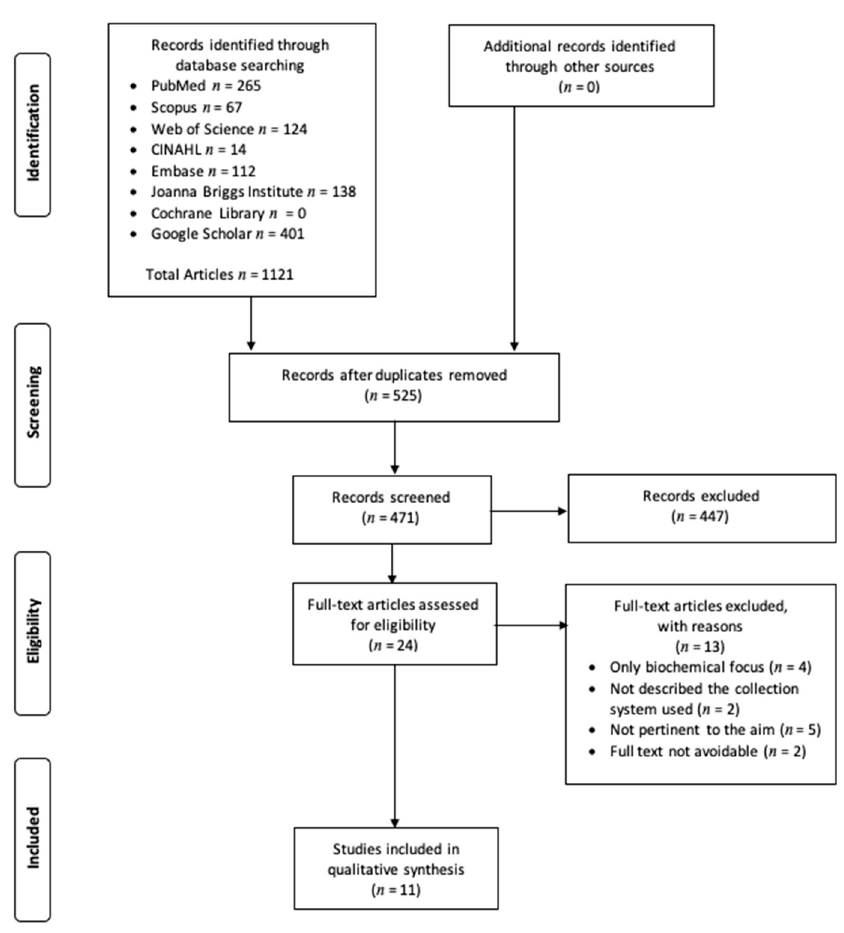
Figure 1. Search and selection flow diagram.